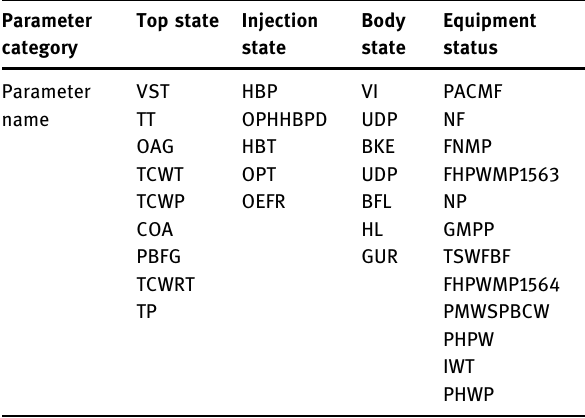
Table 3: Summary table of model input parameters and output